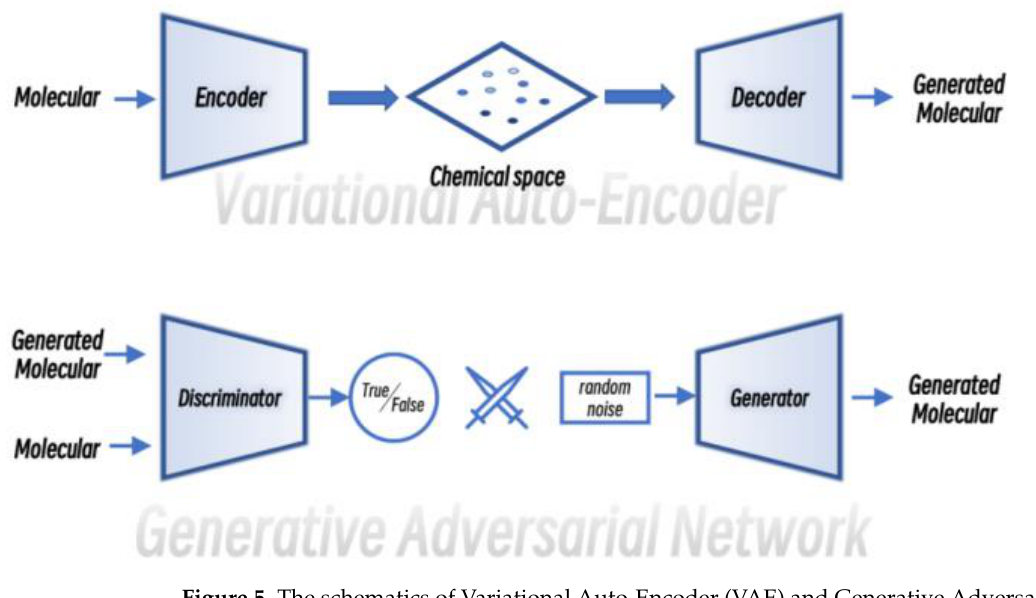
Figure 5. The schematics of Variational Auto-Encoder (VAE) and Generative Adversarial Network (GAN).